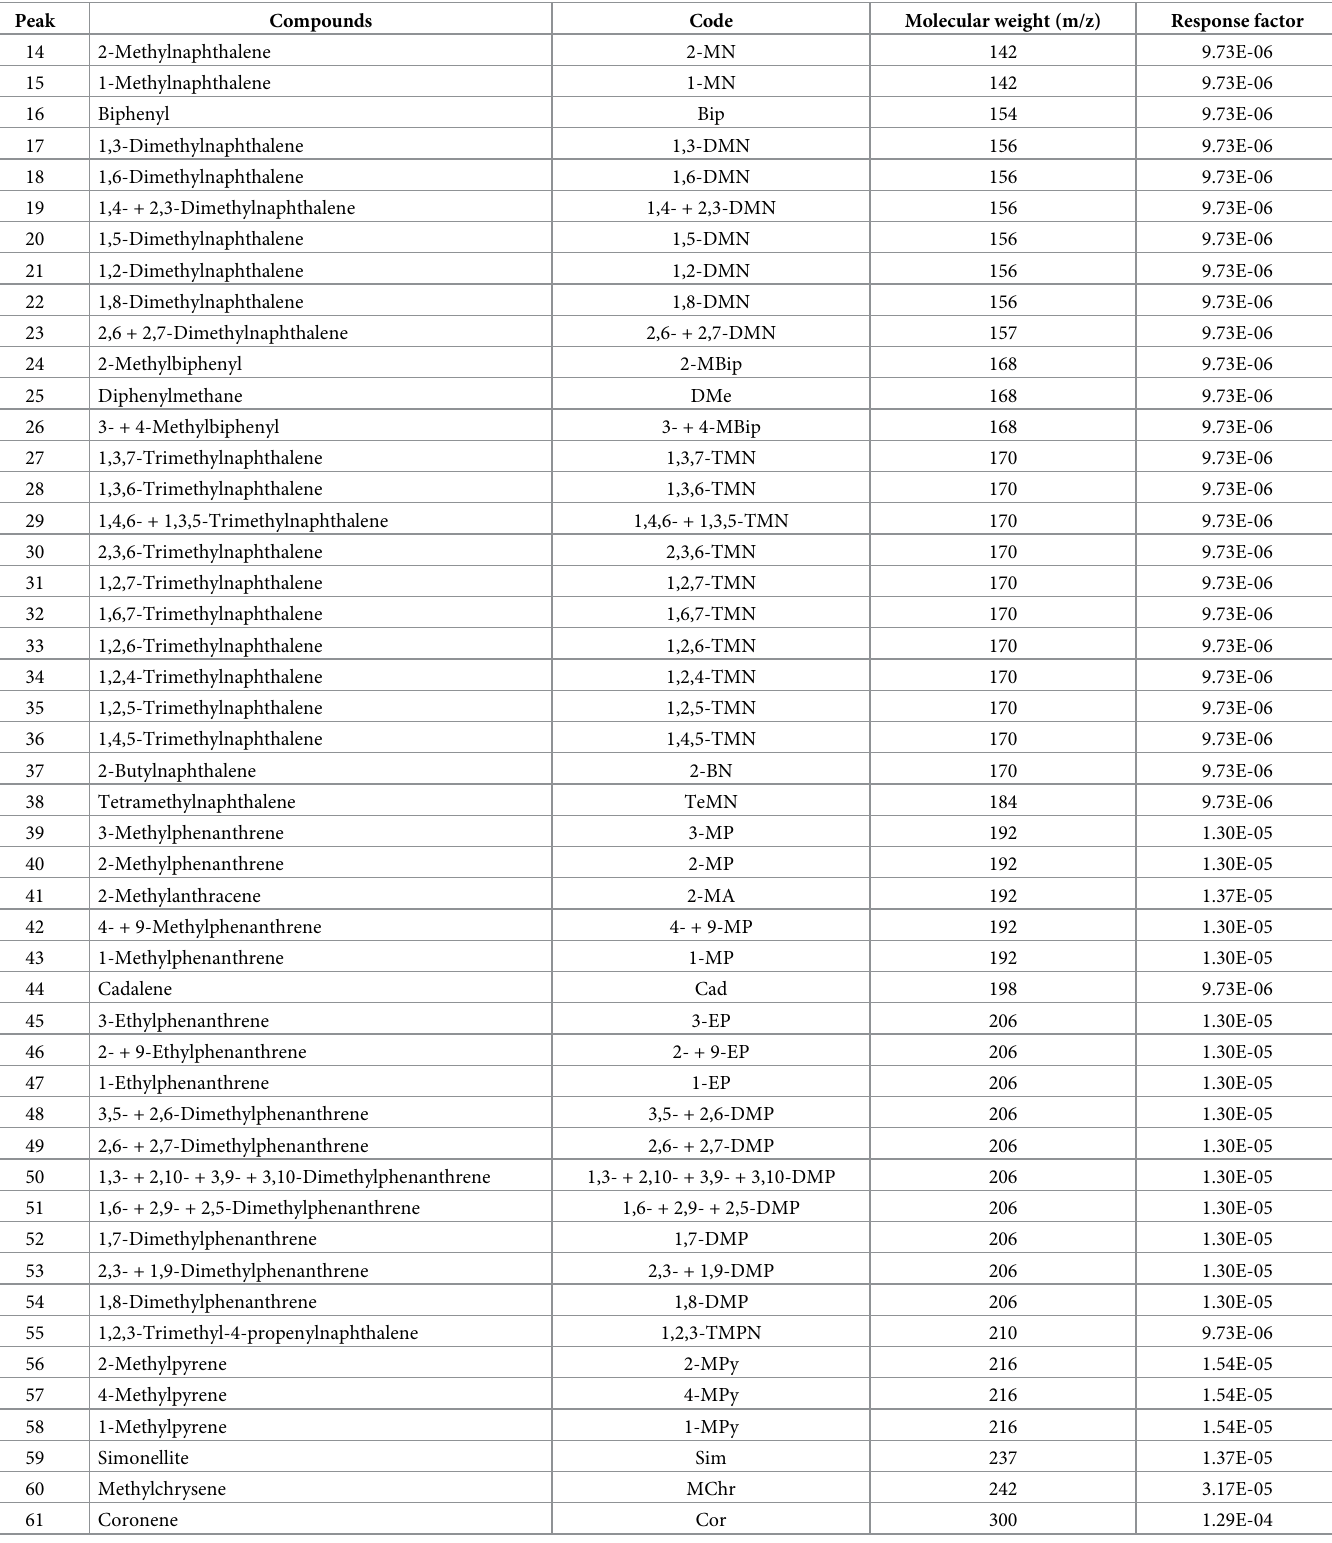
Table 2. List of the measured polycyclic aromatic hydrocarbons (PAHs) identified based on the retention times and mass spectra published by Mita and Shimoyama [35], Marynowski et al. [36], Mita [37], Romero-Sarmiento et al. [38], and Romero-Sarmiento et al. [39].